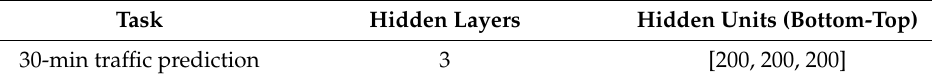
Table A4. Hyperparameters of the SAE when α =